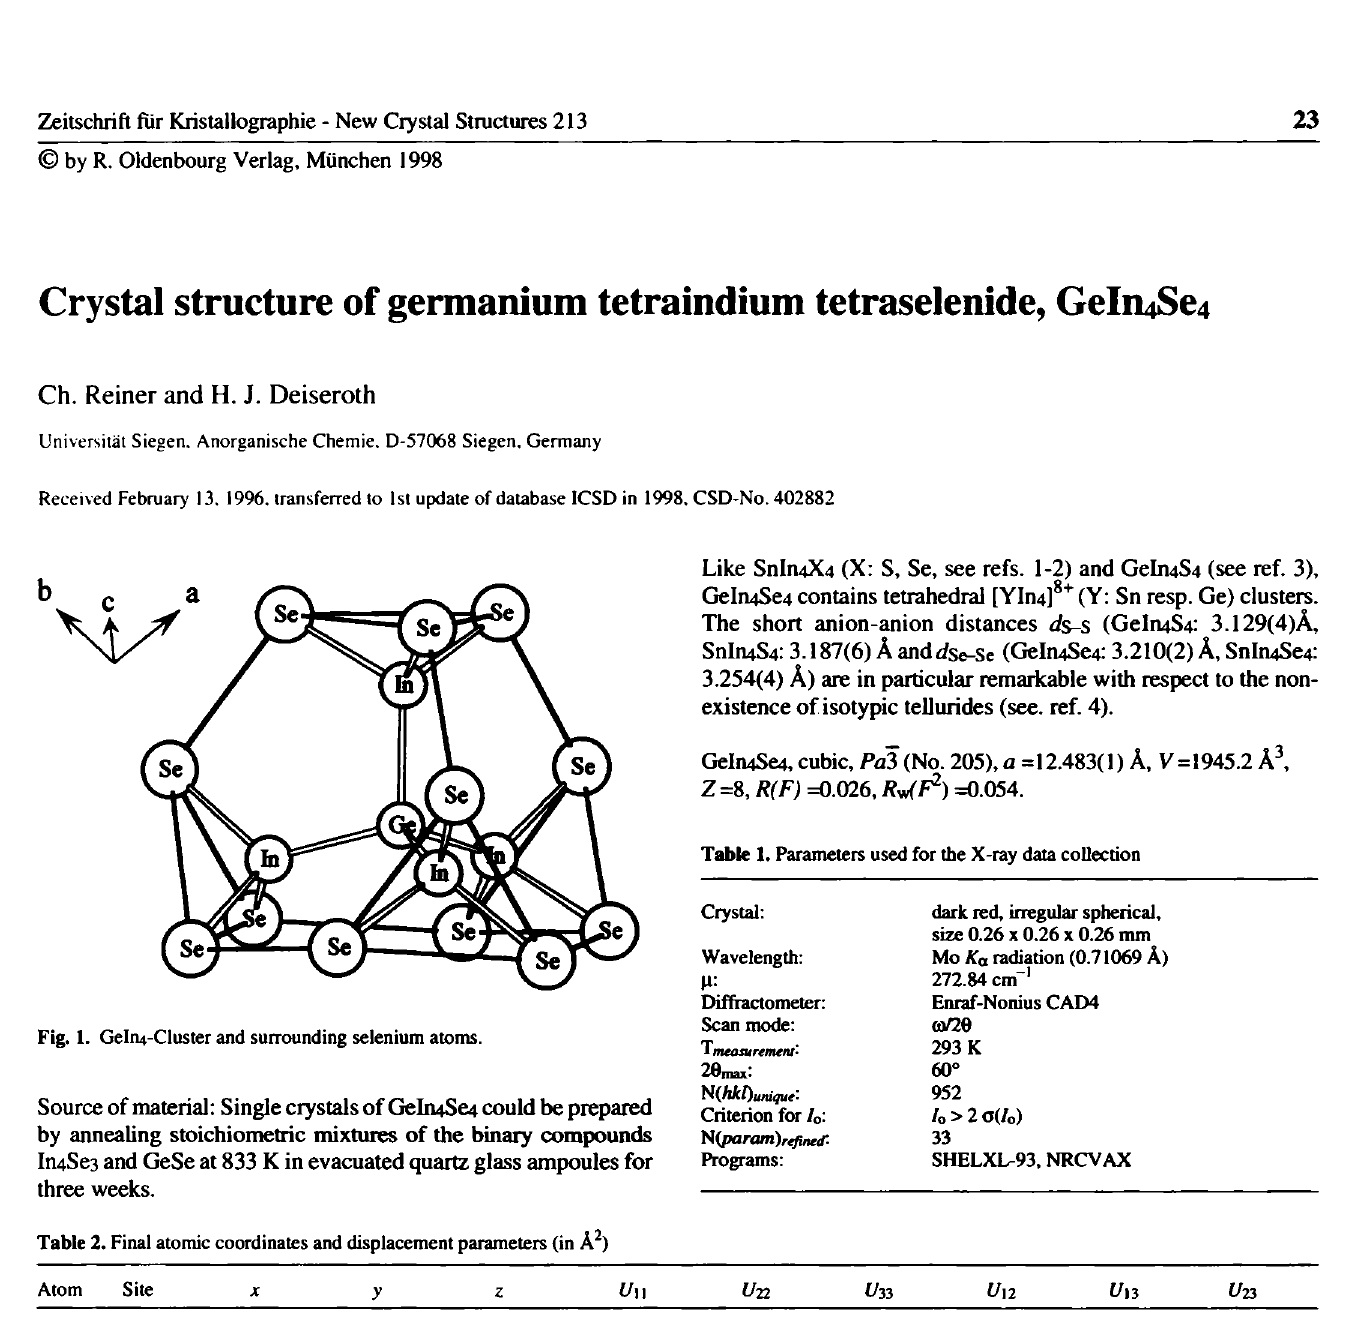
Table 2. Final atomic coordinates and displacement parameters (in Â^)